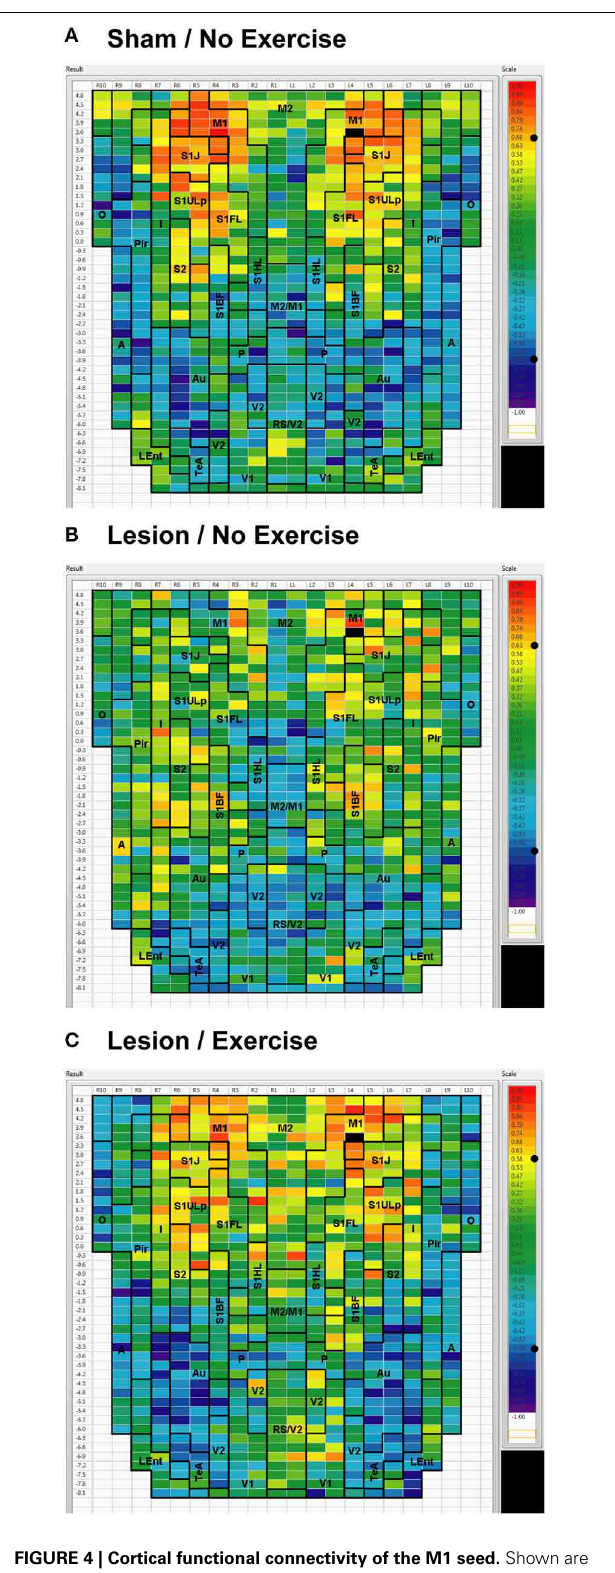
FIGURE 4 | Cortical functional connectivity of the M1 seed. Shown are animals receiving (A) sham treatment, (B) lesion without exercise, and (C) lesion with exercise. The seed is placed in the left anterior,